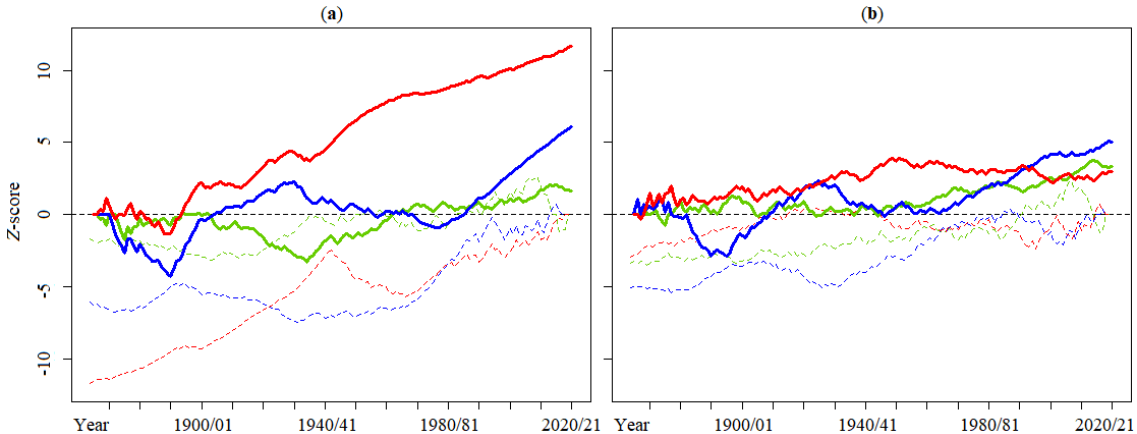
Figure 4. Sequential Mann–Kendall test applied to the annual series, from 1864/65 to 2020/21, of ( a ) rainfall (in green), average Tmin (in blue), average Tmax (in red); ( b ) maximum daily rainfall (in green), minimum daily Tmin (in blue), and maximum daily Tmax (in red). Progressive u ( t ) trend series depicted as solid lines, and retrograde u (cid:48) ( t ) trend series as dashed lines different to